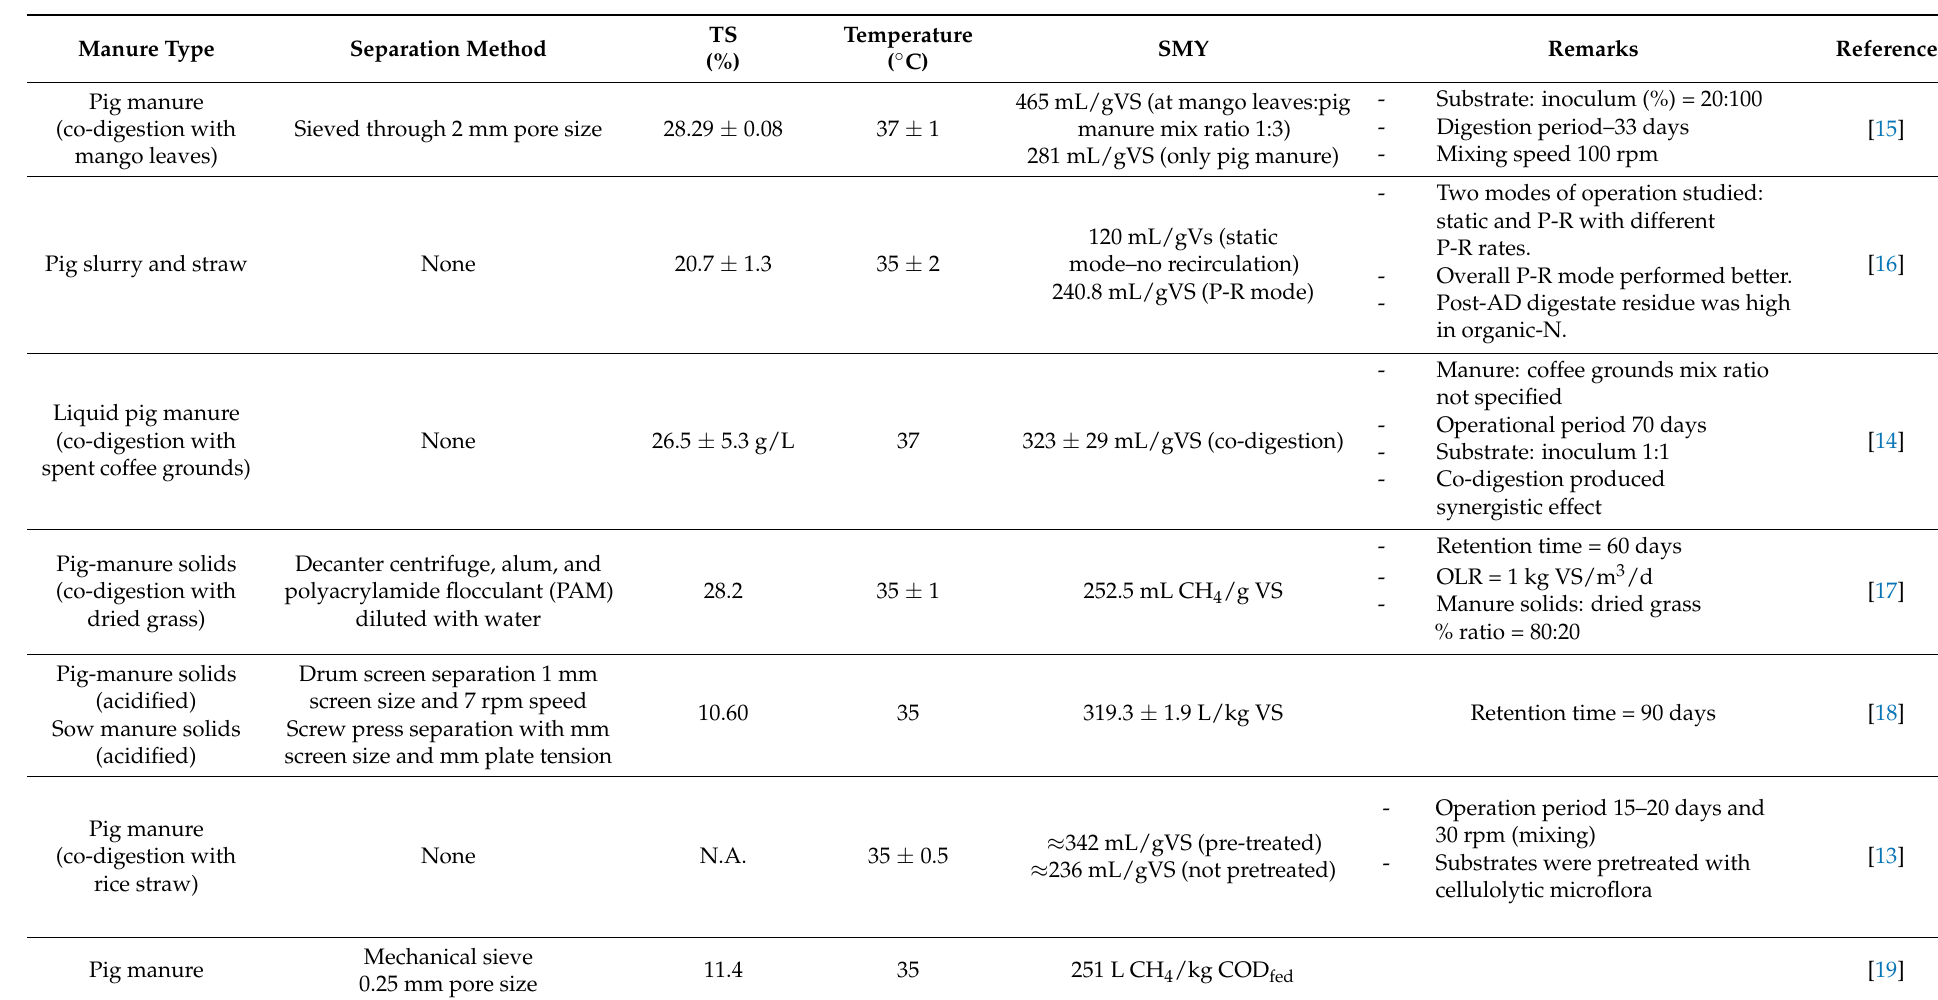
Table 1. Summary of studies on biogas from solids separated from